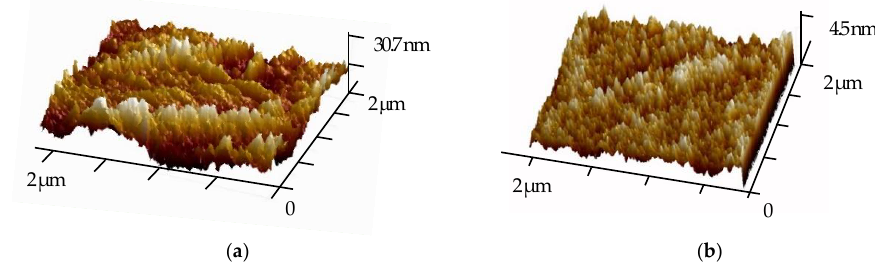
Figure 6. AFM images. ( a ) Wood@PDA–NaOH–OTS; ( b ) Wood@PDA–NaOH/SiO 2